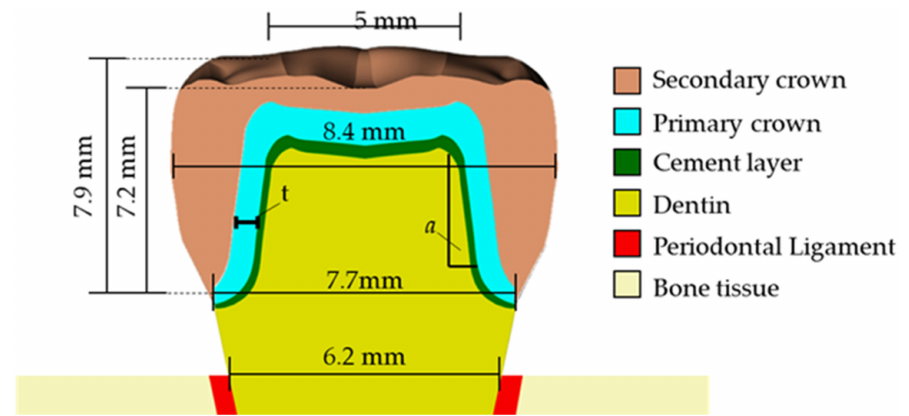
Figure 2. Cross-section of the geometrical model with the designed